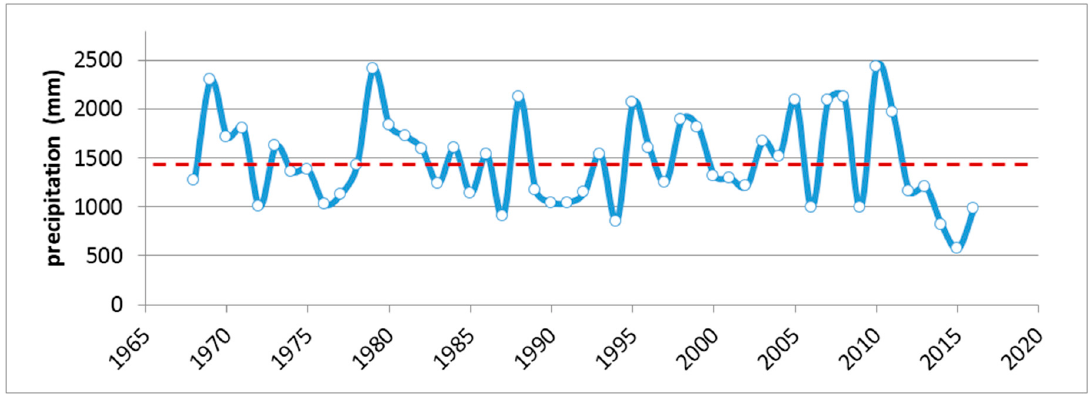
Figure 2. Annual rainfall for study area from [62,76]. Dashed horizontal line represents the mean of 1467 mm for the climatic series of 1968–2016.